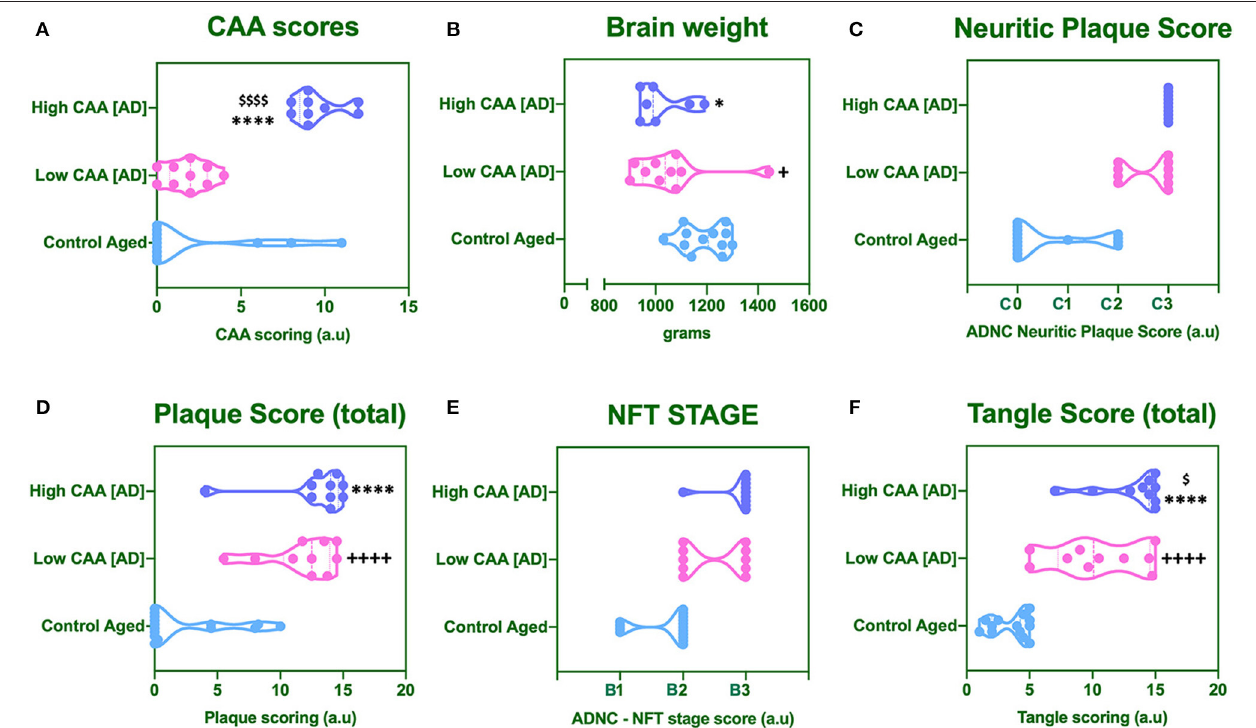
FIGURE 1 | Cerebral amyloid angiopathy [CAA] (A) , mean brain weight in grams (B) and neuropathological scores for Neuritic Plaque (C) , Total Amyloid plaque score (D) , NFT staging (E) , and total tangle pathology score (F) . Data was analyzed by one way ANOVA with Holm-Sidak post-hoc test. * P < 0.05 and **** P < 0.0001 (for Control Aged vs. High CAA group); + P < 0.05 and ++++ P < 0.0001 (for Control Aged vs. Low CAA group); $ P < 0.05, and $$$$ P < 0.0001 (for Low vs. High CAA group).